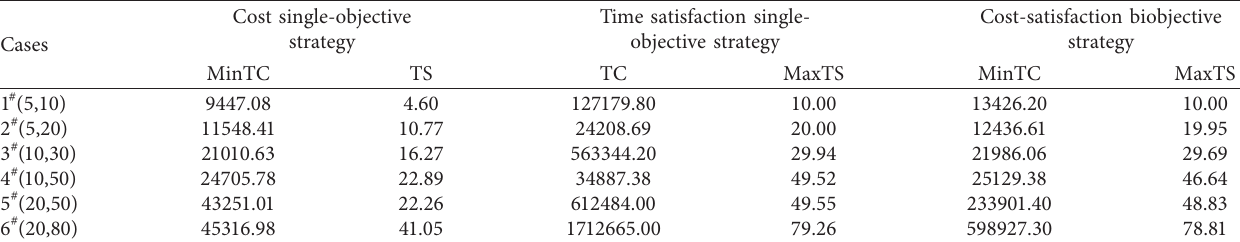
Table 2: Comparison test results between single-objective model and biobjective model weight l 1 � 0.3 and l 2 � 0.7.